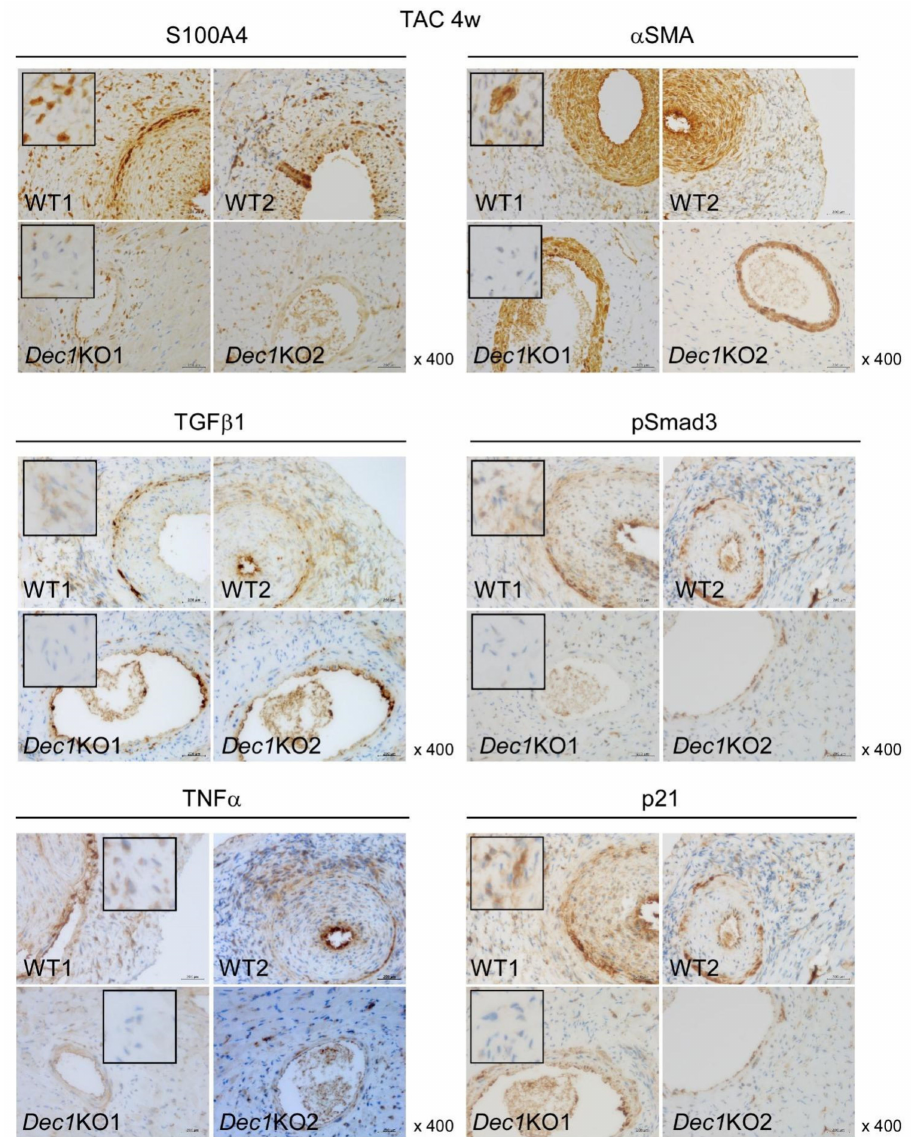
Figure 5. Dec1 deficiency suppresses the expression of S100A4, TGF β 1, pSmad3, TNF α , and p21 at four weeks after TAC. Immunohistochemical detection of S100A4, α SMA, TGF β 1, pSmad3, TNF α , and p21 in cardiac perivascular lesions. Representative images of two independent WT (WT1, WT2) and Dec1 KO ( Dec1 KO1, Dec1 KO2) mice at four weeks after TAC. Magnification 400 × . The black square was magnified from a representative